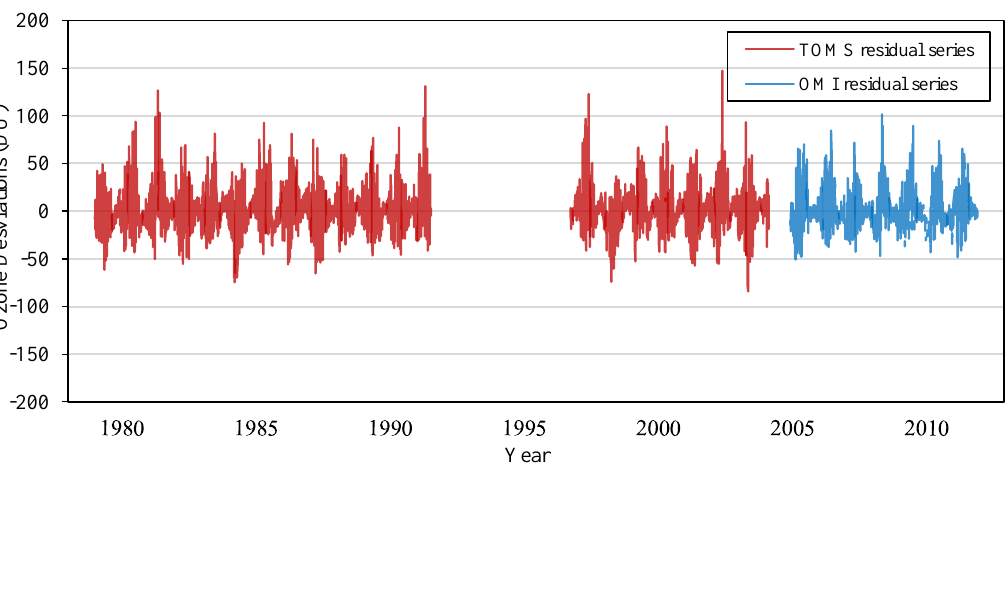
Figure 6. Residual time series over the Yangtze River Delta (31.5°N) for the period